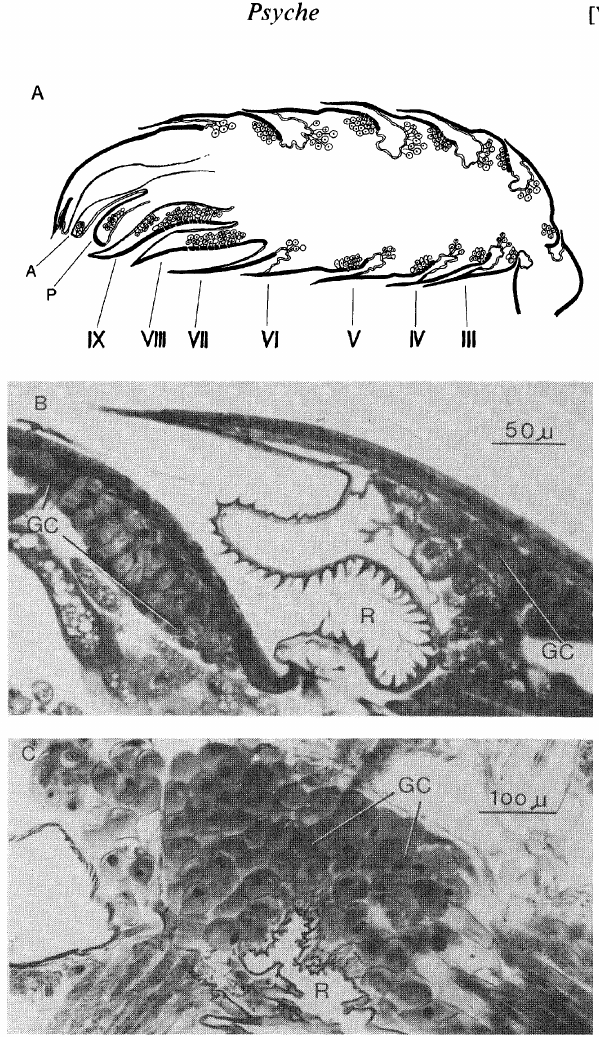
Fig. 4 A. Schematic drawing of a longitudinal section through the gaster of a Neivallvrme.r spec. d’, illustrating the segmental glandular structures. B. Longitudi- nal section through a intersegmental complex-gland (between IVth and Vth tergites). C. longitudinal section through a intersegmental sternal gland of Eciton spec. 6. A=anus; GC=glandular cells; P=part of penis with penis gland; R=